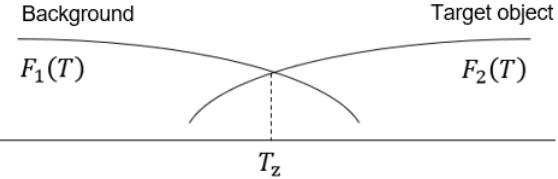
Figure 20. Grayscale value distribution of background and target object.